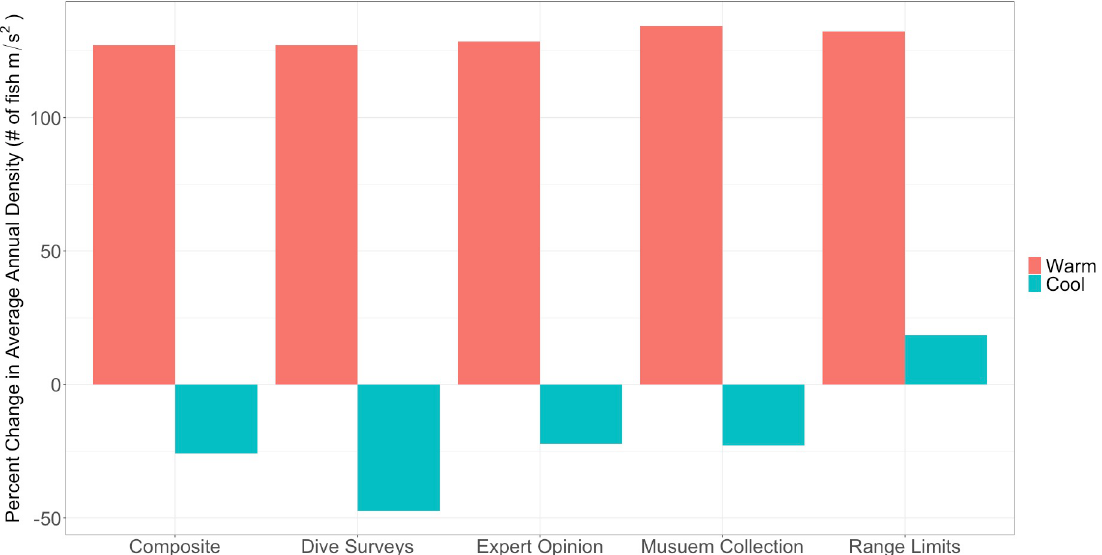
Fig 1. Changes in average annual fish densities. Percent changes in average annual fish densities for warm (red bars) and cool (blue bars) species are shown for each classification data source for the years prior to (2012–2013) and after (2014–2015) the onset of the marine heatwave.